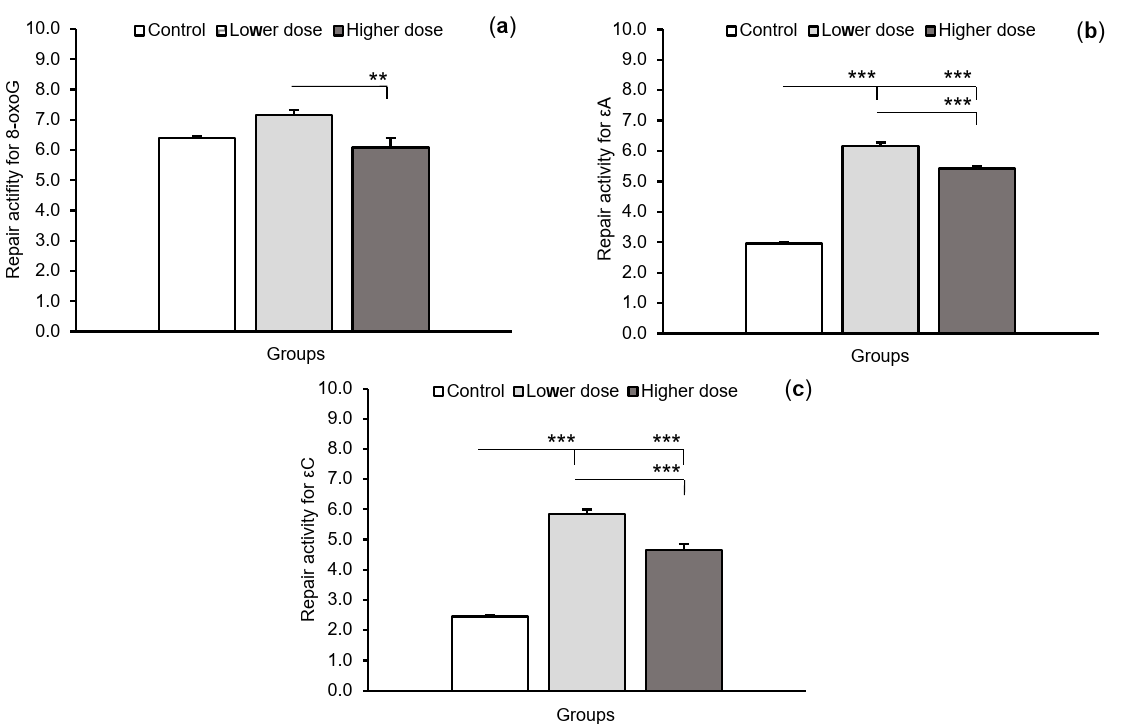
Figure 4. Repair activities (fmol/ µ g protein/h) for 8-oxoguanine (8-oxoG), ( a ) 1,N6-ethenoadenine ( ε A), ( b ) and 3,N4-ethenocytosine ( ε C), ( c ) in the hippocampal CA1 field of sheep infused with the lower (20 μ g in total) and higher (100 μ g in total) dose of kynurenic acid into the third ventricle of the brain. Significance of differences: ** p < 0.01, *** p < 0.001.